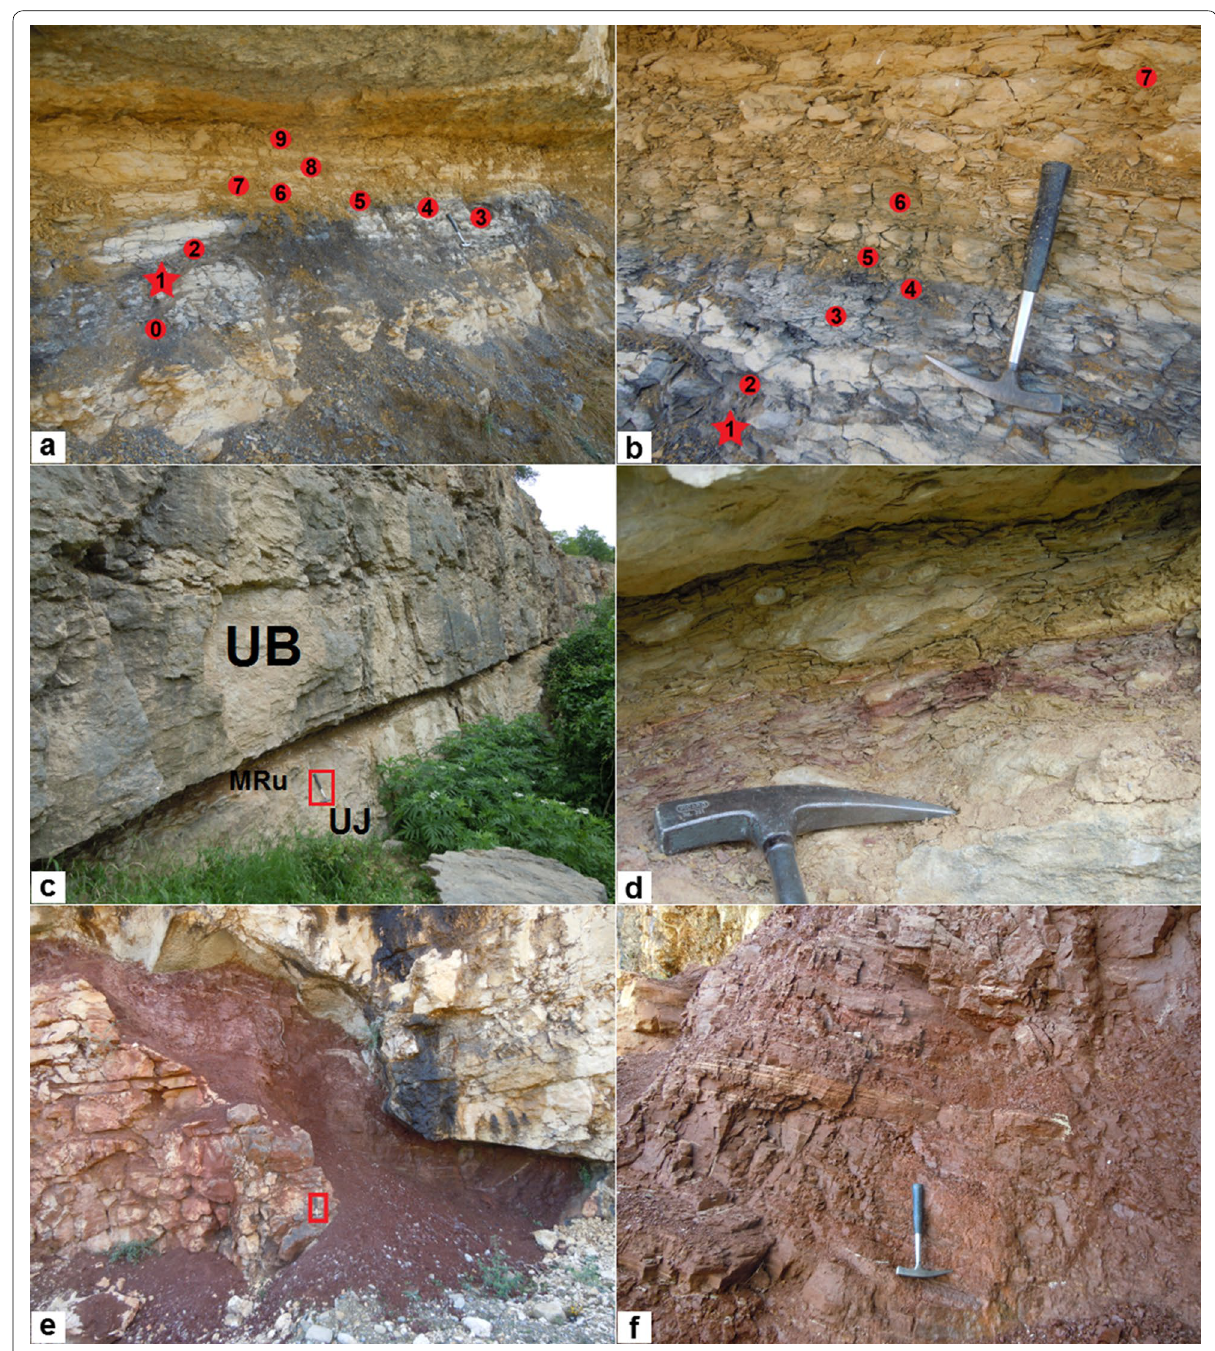
Fig. 14 a, b La Sarraz–Les Buis quarry Sect. (8/3/2020), channel infill of Marnes de la Russille (MRu) with LSBMRu0‑9 samples positioned (red star and circles), the transitional change of colour between LSBMRu4 and LSBMRu5 indicates the Early/Late Barremian boundary. c, d Eclépens quarry Sect. (24/6/2018), transition of the highest Marnes de la Russille (MRu) between Urgonien Jaune (UJ) and Urgonien Blanc (UB) facies, with coloured marls partly rubefied (d, sample ECMRu10). e, f La Sarraz–Les Buis quarry Sect. (8/3/2020), paleokarst with Late Eocene infilling of red clays and marls (Siderolithic deposits) in the lower part of the massive UB limestones. Scale: hammer (red frame in c, e)